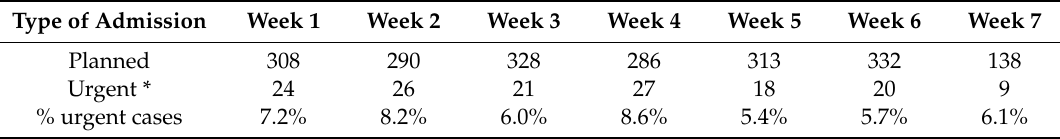
Table 1. Planned vs. urgent acute admissions between 24 February 2019 and 12 April 2019, by week. Type of Admission